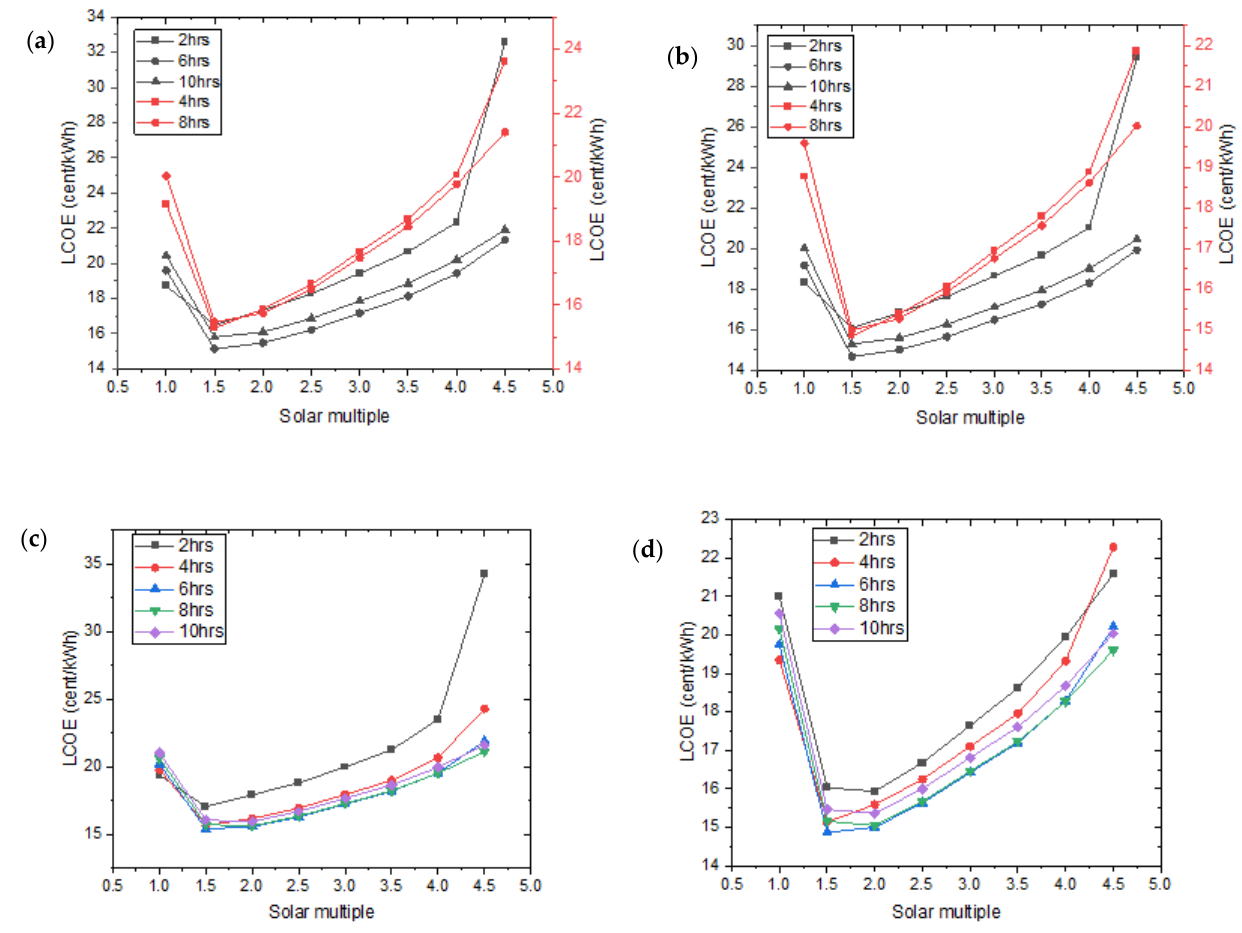
Figure 5. Effect of TES on the cost effectiveness of the various scenarios: sCO 2 ( a ) HTF A ( b ) HTF B, Rankine ( c ) HTF A ( d ) HTF B.